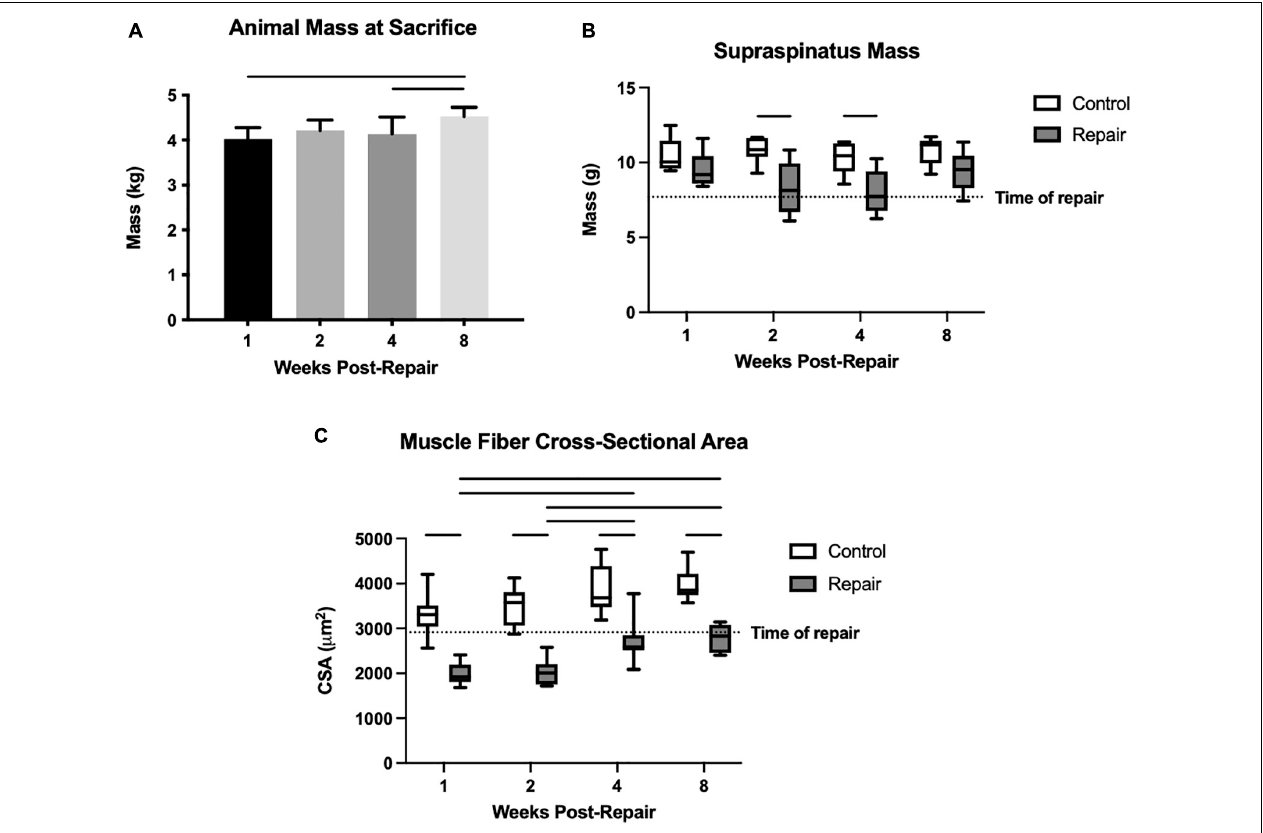
FIGURE 1 | Overall animal mass increased significantly over time (A) . Mean supraspinatus mass remained stable on the control side, but the repaired side decreased significantly in mass compared to control at 2 and 4 weeks post-repair (B) . Muscle fiber cross-sectional area (CSA) was decreased compared to control at every timepoint, but increased from 1–2 weeks to 4–8 weeks, while the control fiber CSA remained similar throughout (C) . Data presented as mean ± SD for bar graph, or minimum and maximum for box plot, N = 8 per timepoint. Significant comparisons ( p < 0.05) within timepoint or within treatment group are indicated by horizontal line. Dotted line represents historical control data from previous study (Vargas-Vila et al., 2021) at 8 weeks after tenotomy (time of repair).